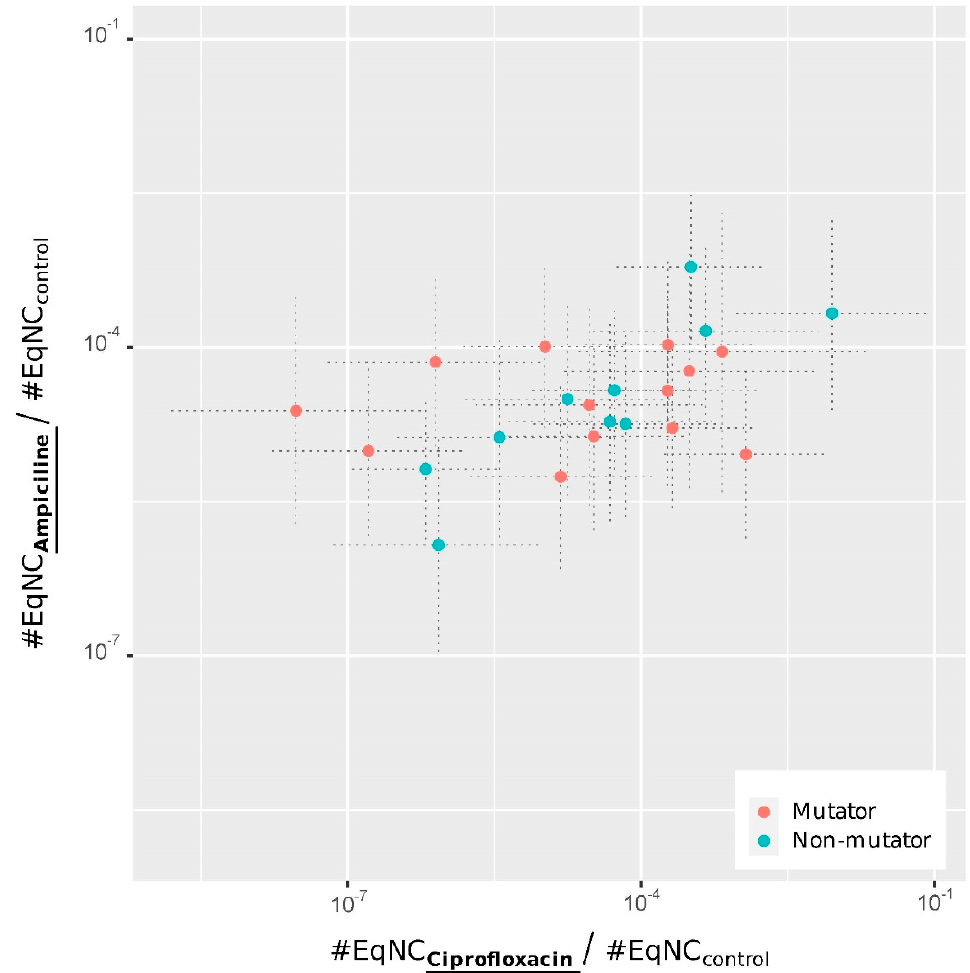
Figure 1. Persistence to ampicillin vs. ciprofloxacin in evolved clones sampled from each of the 12 LTEE populations.